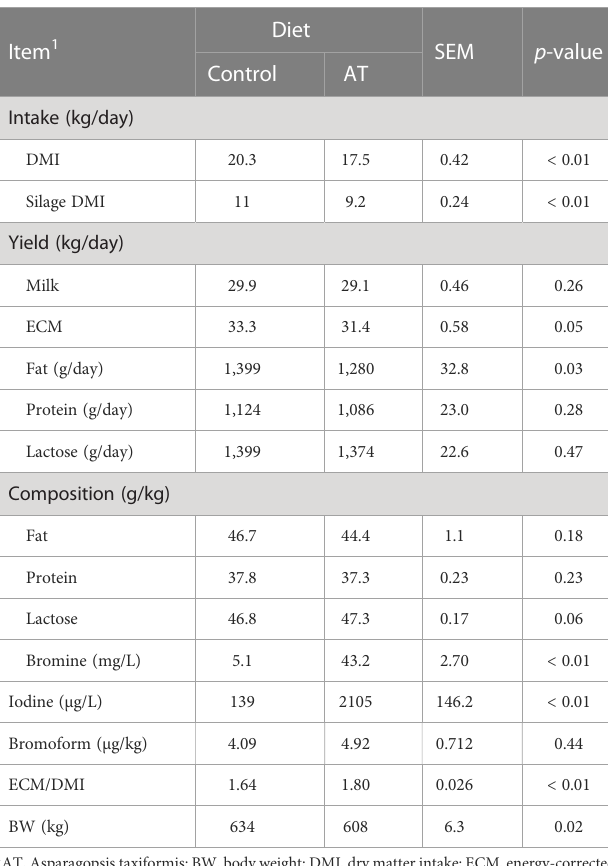
TABLE 2 Ingredient and chemical composition of experimental total mixed ration fed to dairy cows. Item